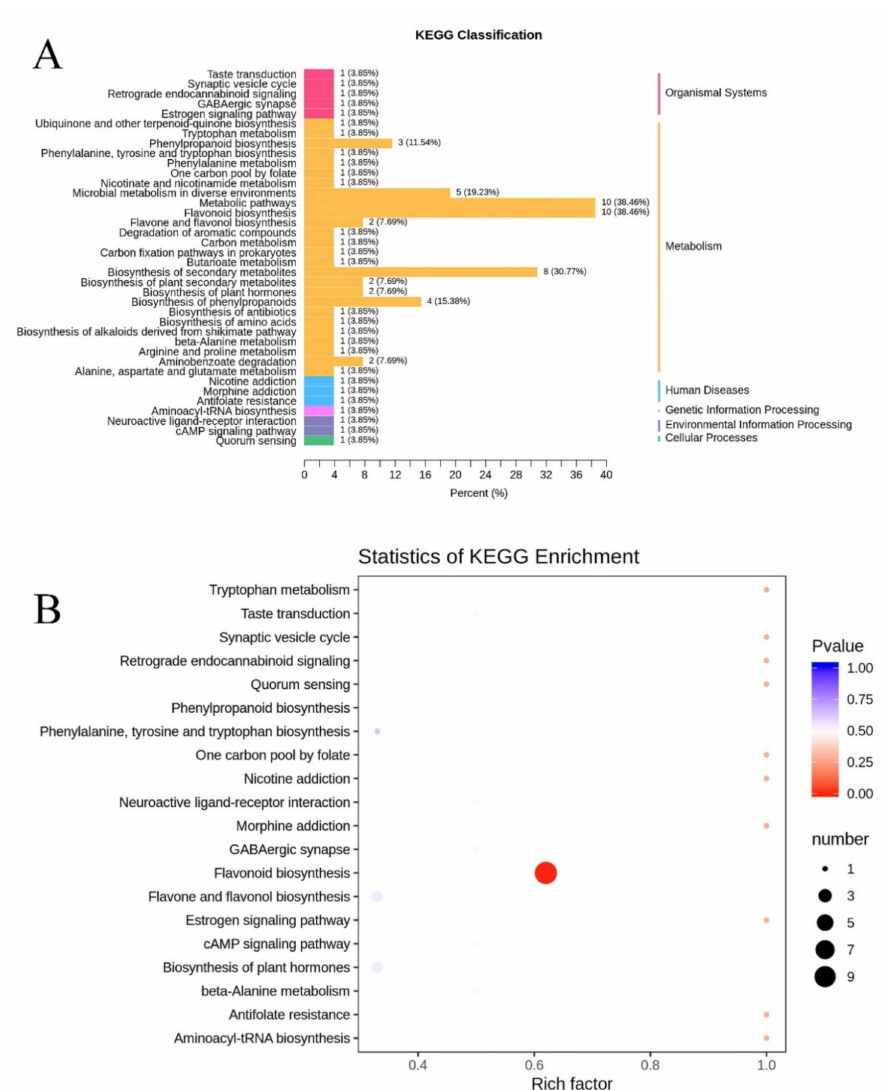
Figure4. ( A )EnrichmentofthedifferentialmetabolitestohighlighttheKEGGpathway.